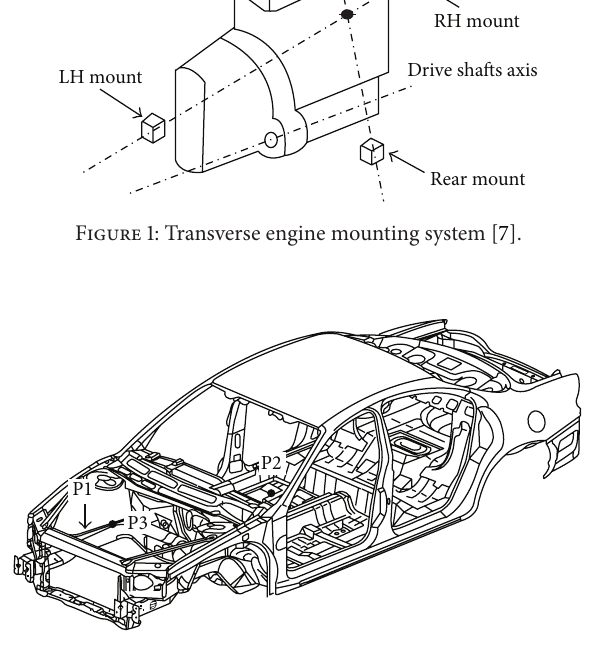
(Figure 2). By calculating the ratio of 𝐹 approximation of apparent mass could be got (Figure